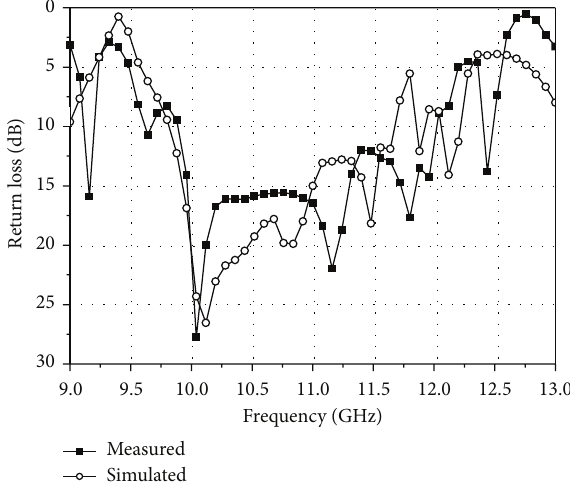
Figure 8: Simulated and measured return losses against frequency.